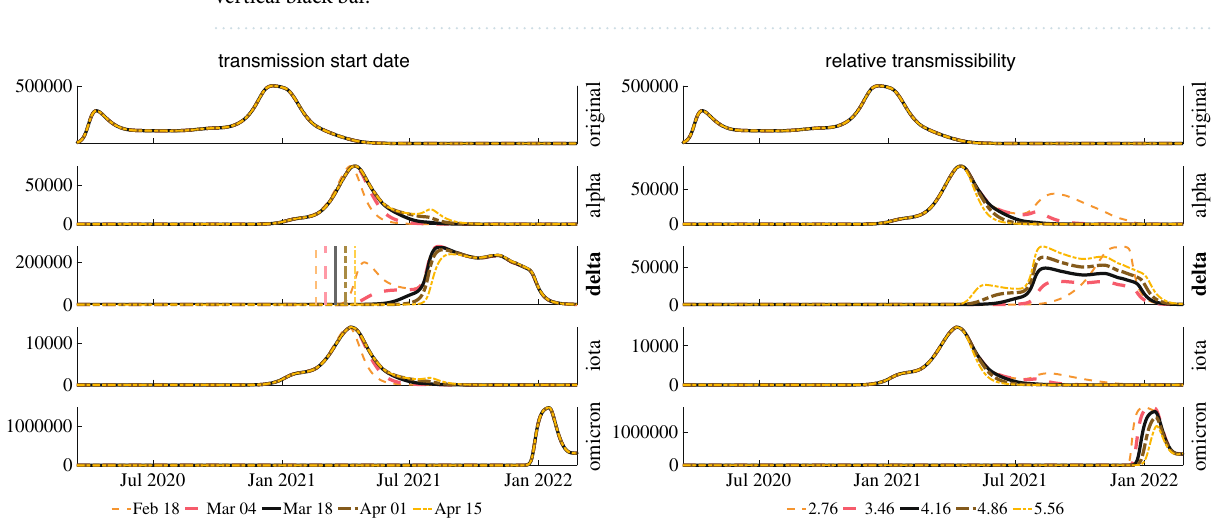
Figure 4. Results of the model fit to each of the dominant variants in the United States and India (dotted), plotted against the estimated actual daily cases (bar). The transmission start date of each variant is indicated by a vertical black bar.